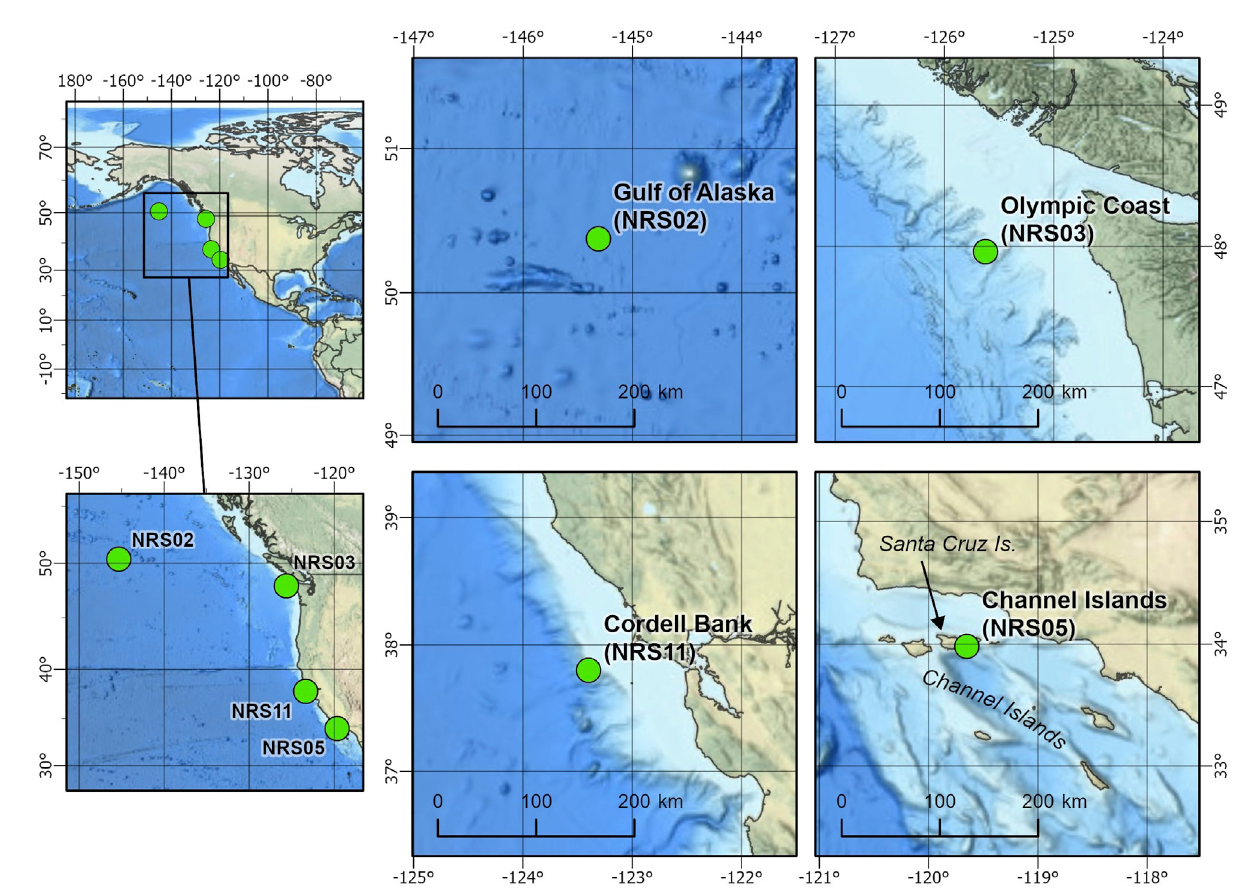
FIGURE 1 Locations of the NOAA-NPS Ocean Noise Reference Station Network (NRS) recording sites used for this study: Gulf of Alaska (NRS02), Olympic Coast (NRS03), Cordell Bank (NRS11), and Channel Islands (NRS05).